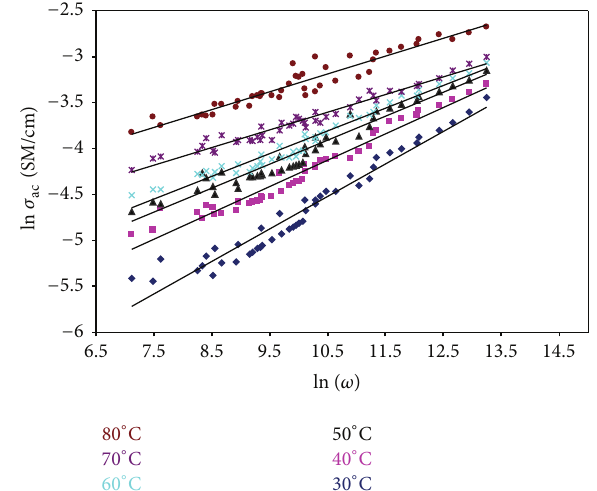
Figure 17: ac conductivity versus angular frequency for poly-o-phenylenediamine (POPDA) with frequency at different temperatures.